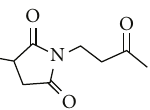
Figure 1: Dendrimeric peptides used in this